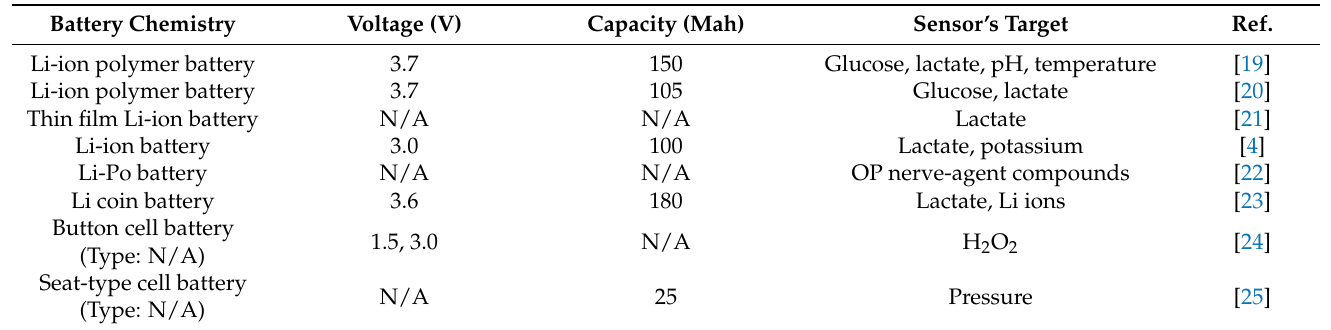
Table 3. Typical low-modulus and flexible substrate wearable sensors powered by